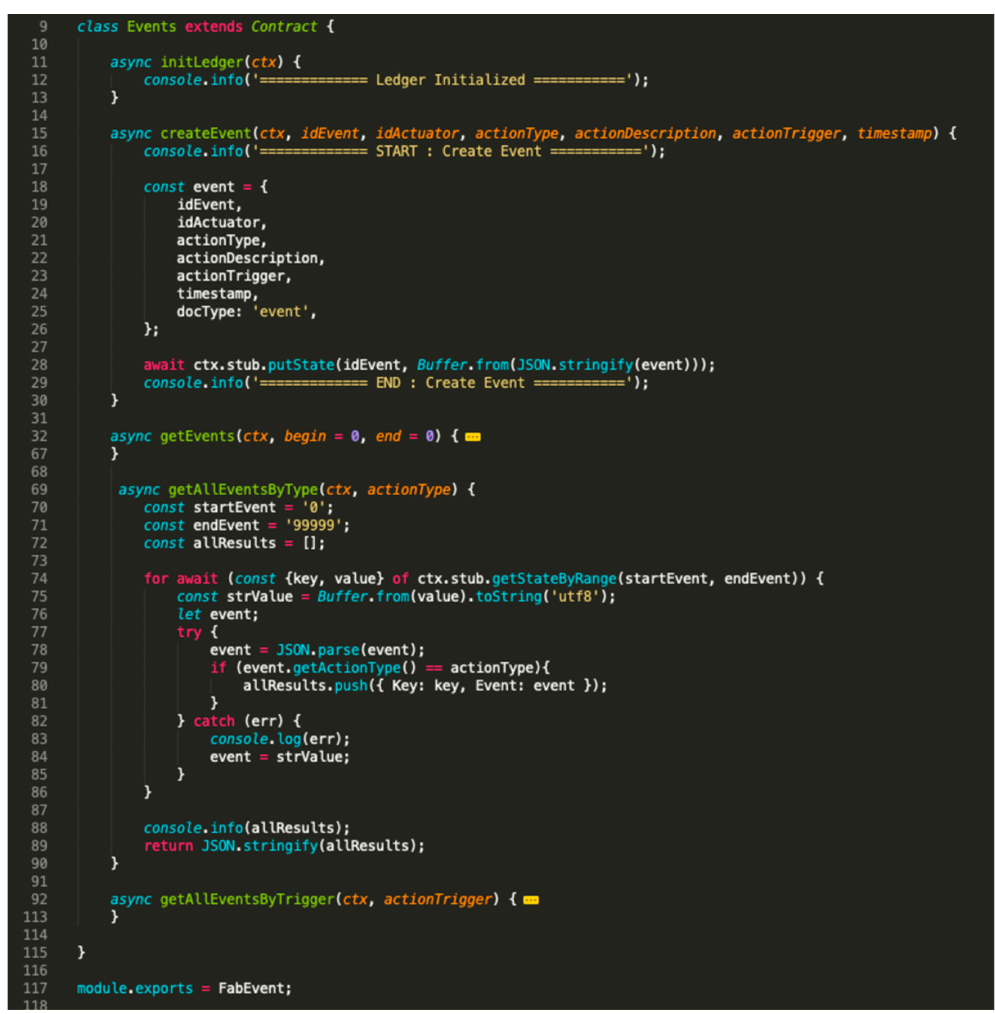
Figure 8. Smart contract to handle